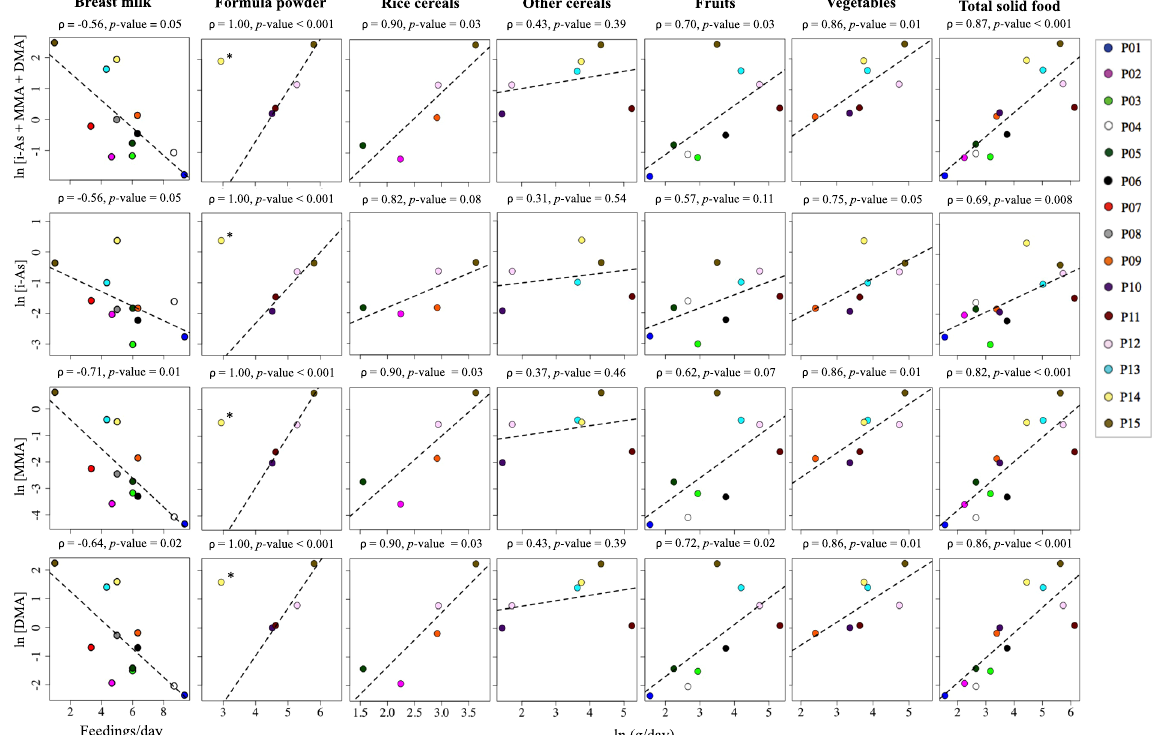
Figure 2. Concentrations of infant urinary arsenic species in relation to intake of specific foods at 6 months of age. Each infant is identified by a unique color. Spearman’s correlation coefficient and p -value for each dietary item. Urinary arsenic species concentration and solid food consumption were natural logarithm transformed to help visualization. The least-squares regression line is also included to help visualize associations. * Infant P14 was not included in Spearman’s correlation between urinary arsenic species content and the formula powder intake level